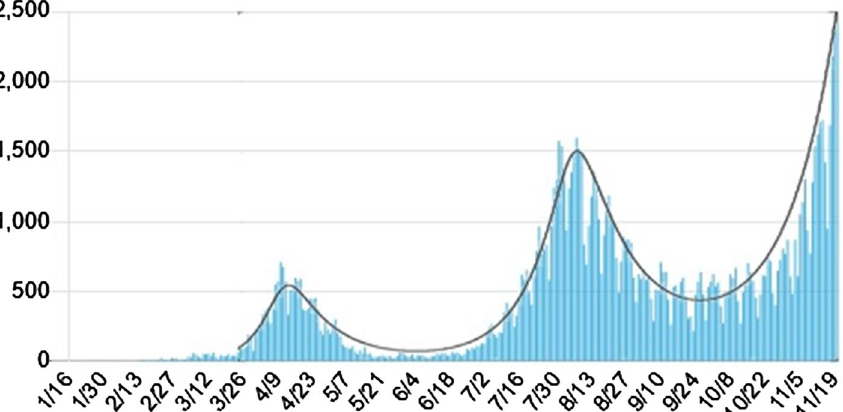
Figure 1. The daily confirmed new cases � Q ( t ) in Japan from March 26 to November 20, 2020 20 . The solid curve is a fitting by the piece-wise hyperbolic tangent functions for the transmission coefficient with parameters listed in Table 1.